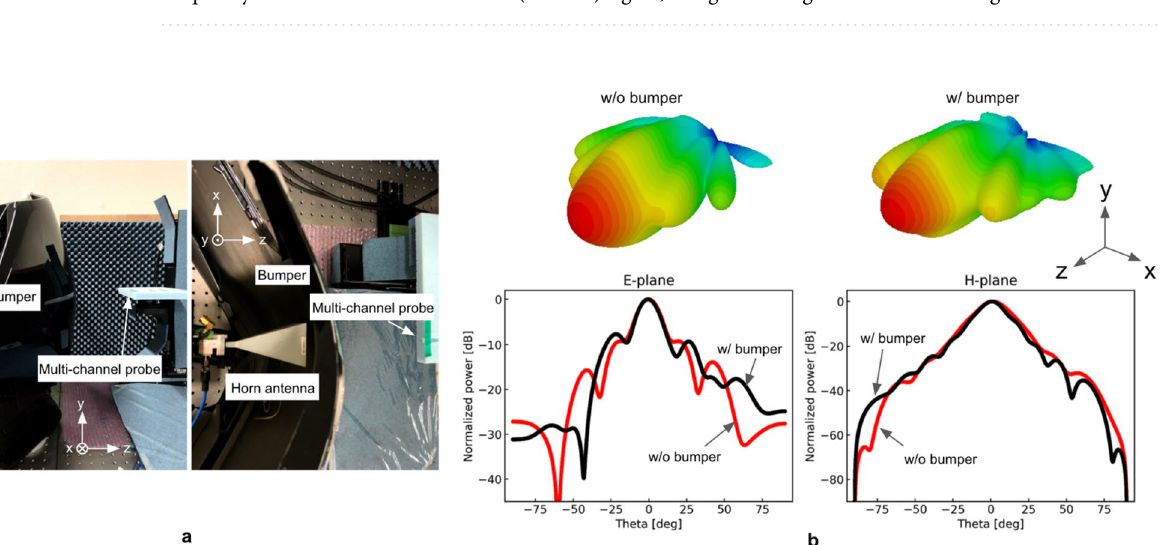
Table 1. Characteristics of radiation pattern. The measurement is conducted for a 24 GHz ± 40 MHz frequency-modulated continuous wave (FMCW) signal, using the configuration shown in Fig. 1c.